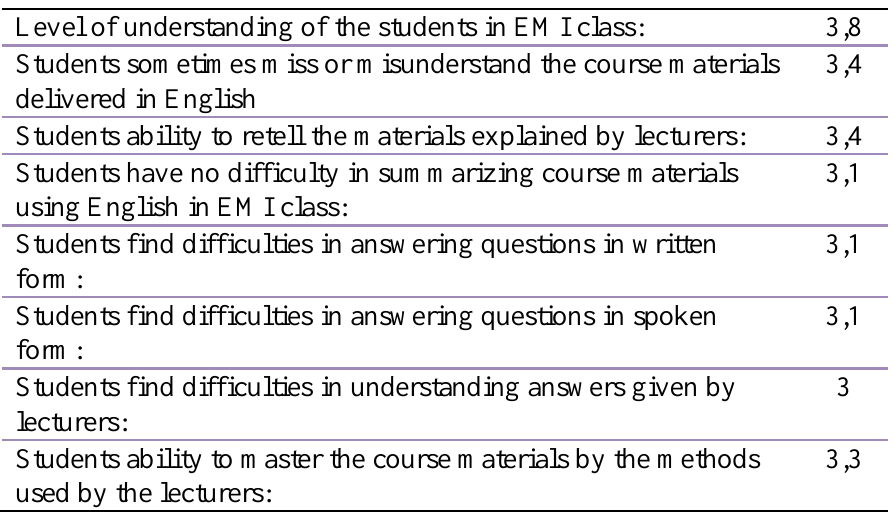
Table 8. Understanding of Students on the